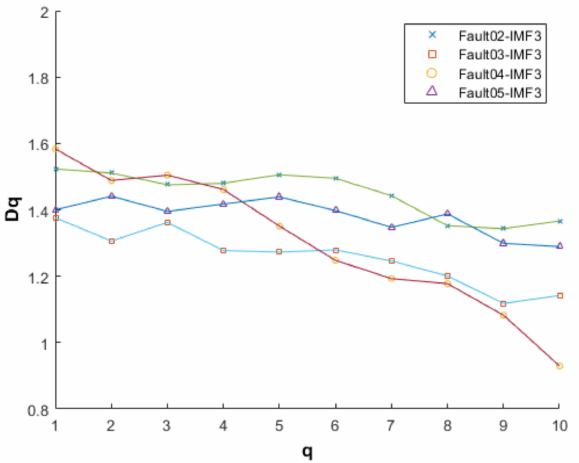
Figure 20. IMF3‑EMD mathematical morphology fractal dimension map.